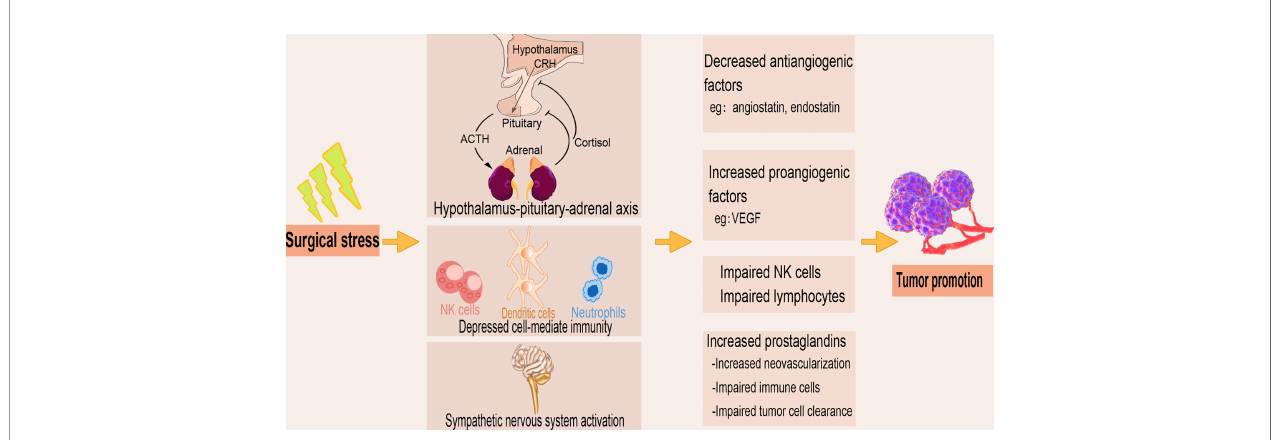
FIGURE 3 | The tumor-promoting effect of surgical stress. The stress produced during the surgical removal of tumors activates the sympathetic nervous system and the hypothalamus-pituitary-adrenal axis and as well depresses the cell-mediated immunity. Surgical stress also decreases antiangiogenic factors, increases proangiogenic factors, and upregulates prostaglandins, leading to impaired immune cell function and tumor cell